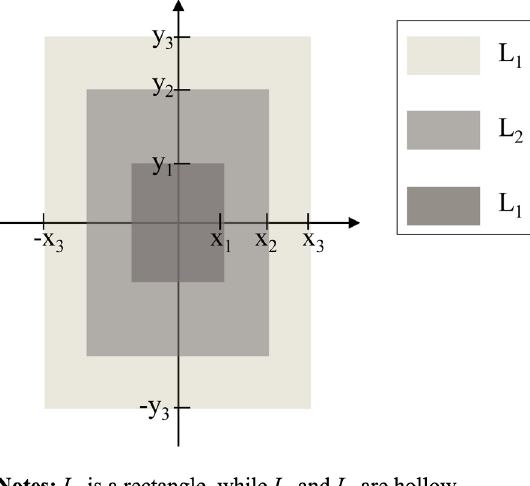
Table I. Strategies for generating TMT Part A and Part B with the DAC approach